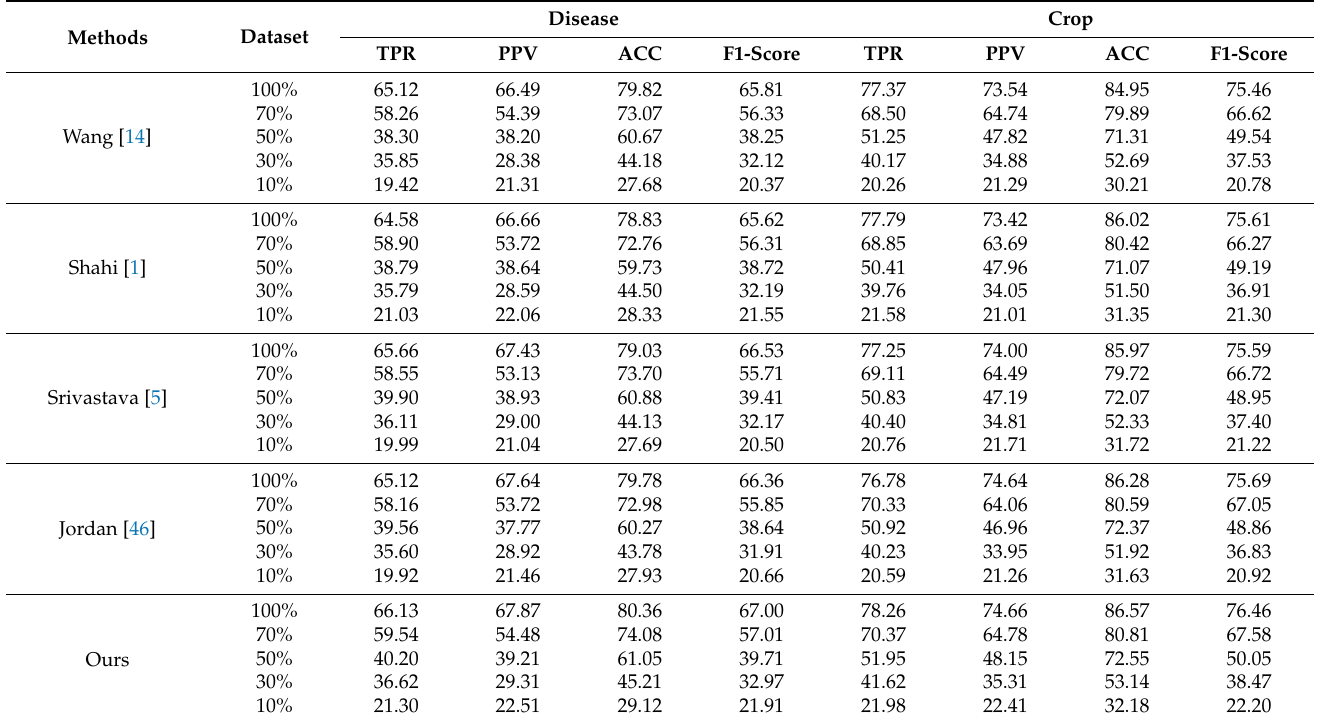
Table 32. Comparison of accuracies achieved by the proposed PI-CNN and the existing methods in the original and reduced datasets. The accuracies were achieved in the PlantDoc dataset (unit: